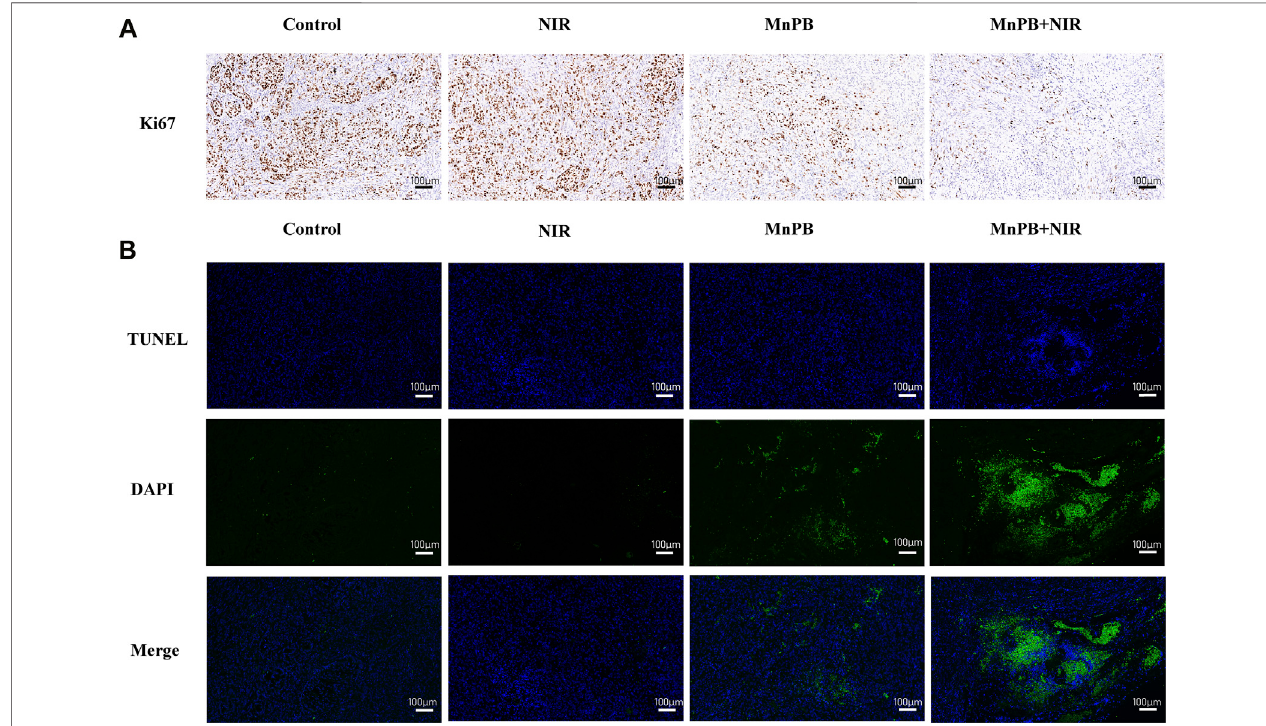
FIGURE 8 | The MnPB NPs inhibit the growth of non-small lung cancer in vivo . (A) Ki67 staining and (B) TUNEL staining images of tumors. Scale bar, 100 μ m.